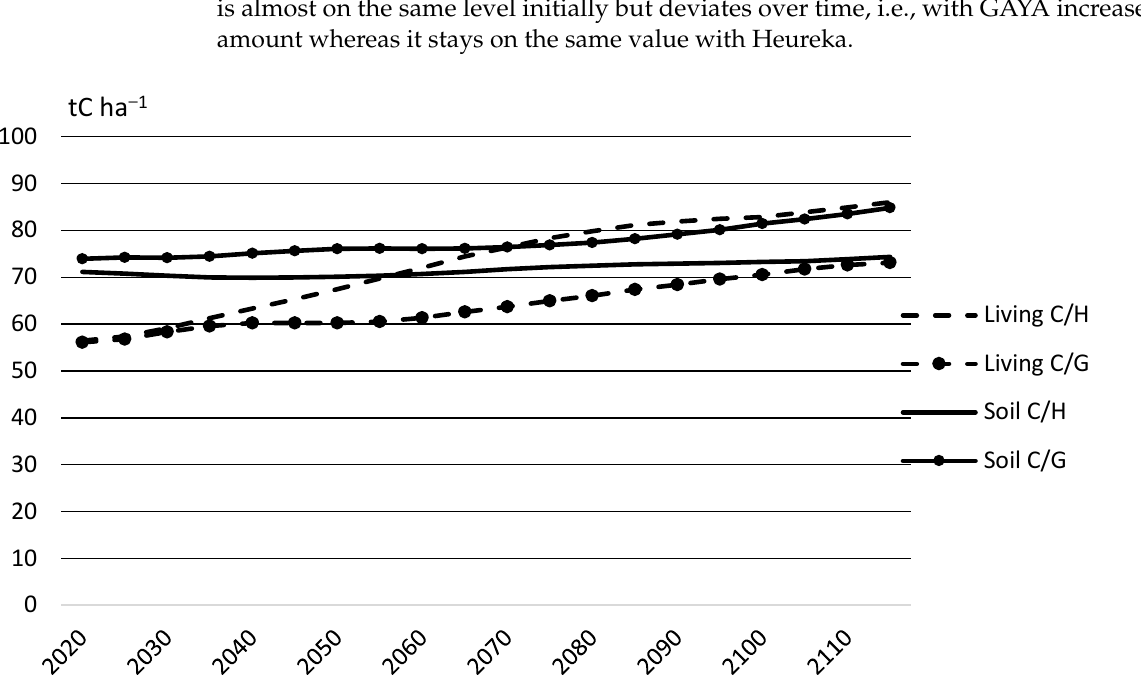
Figure 8. Pools of carbon in living matter and soil with GAYA (/G) and Heureka (/H).